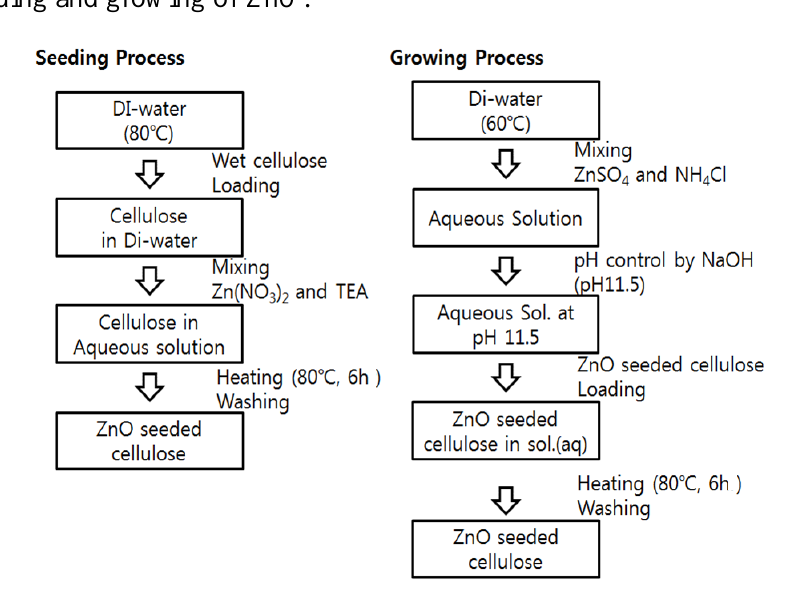
Figure 1. Schematic of CEZOHN (cellulose ZnO hybrid nanocomposite) fabrication process: seeding and growing of